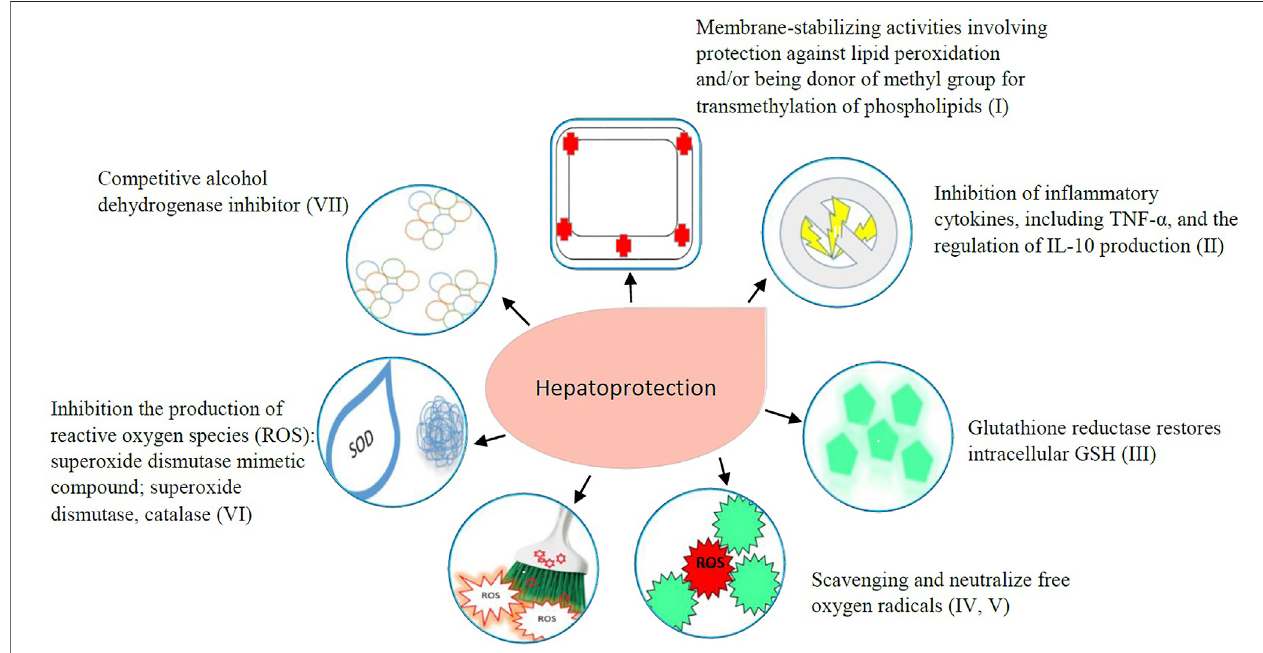
FIGURE2| Mechanismofhepatoprotectiveeffectofevaluatedintervetions:Bicyclol:I,II,IV,V;Calmangafodipir:III,VI;Cytisinamidophosphate:I,IV,V;Livina:III,IV, V,VI;MagnesiumIsoglycyrrhizinate:II,IV,V;Picroliv:I,IV,V,VI;PlasmaExchange:II;RadixPaeoniaeRubra:II,IV,V;S-adenosylmethionine:I,II,III;4-Methylpyrazole:VII.